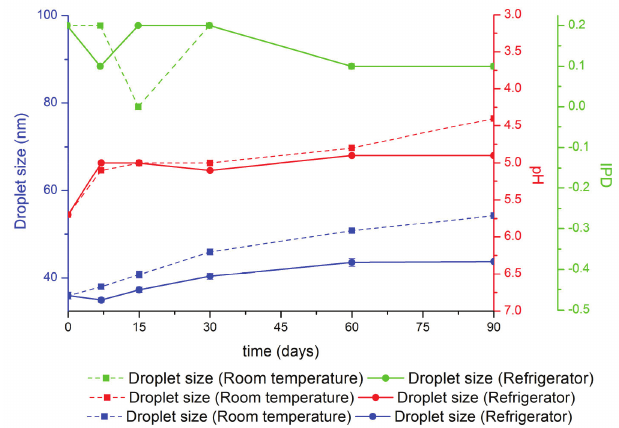
FIGURE 1 - Nanoemulsion F3: Droplet size,